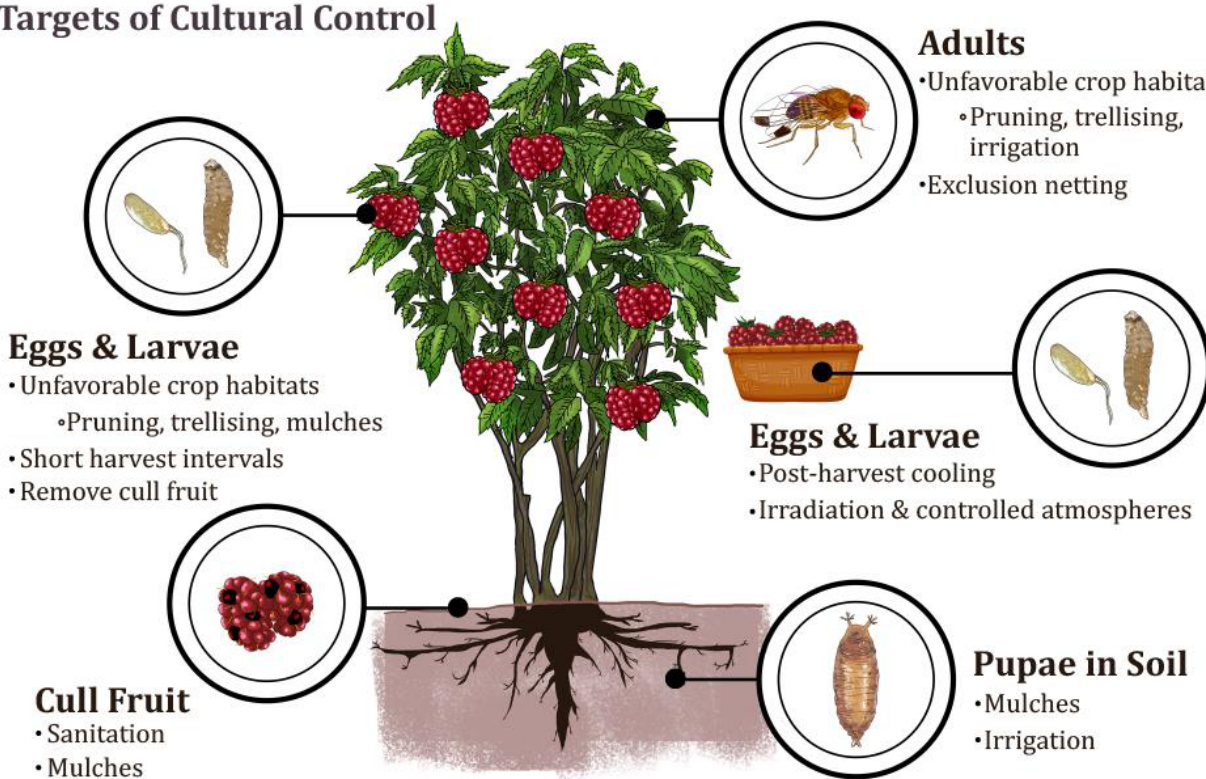
Figure 1. Life stages of D. suzukii targeted by cultural control practices. Figure Credit: Naiade Caparelli.